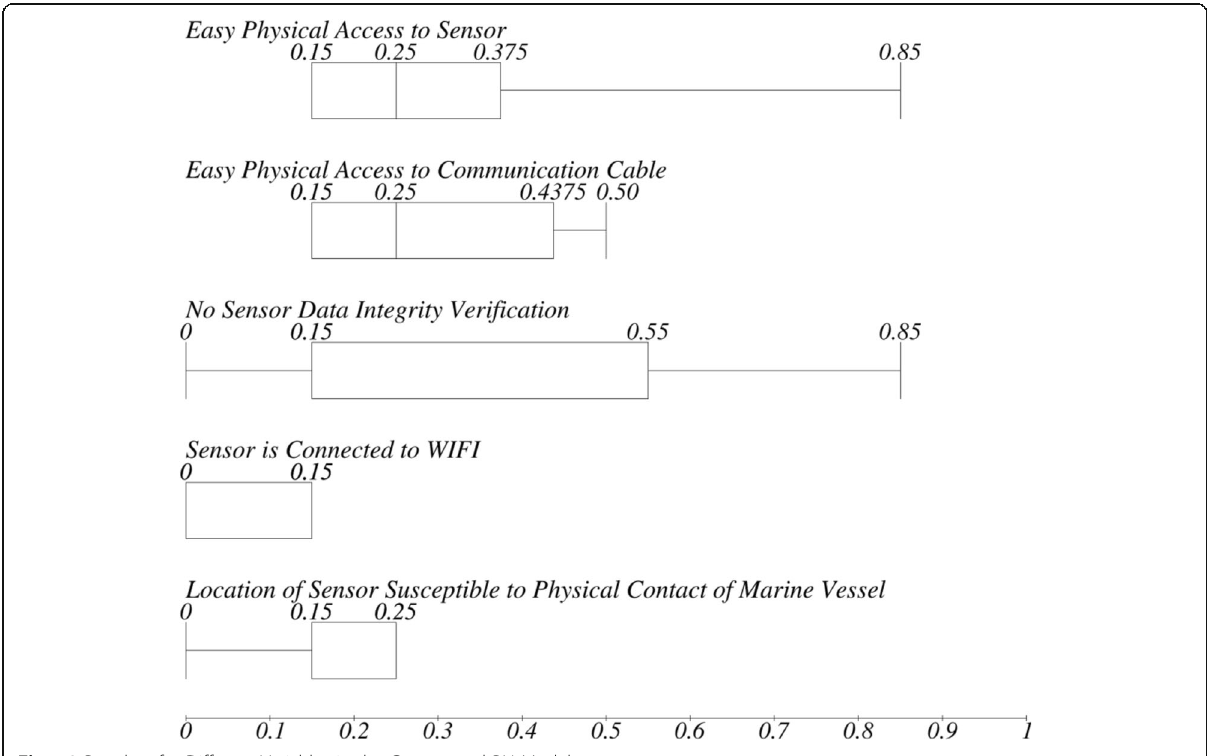
Fig. 10 Boxplots for Different Variables in the Constructed BN